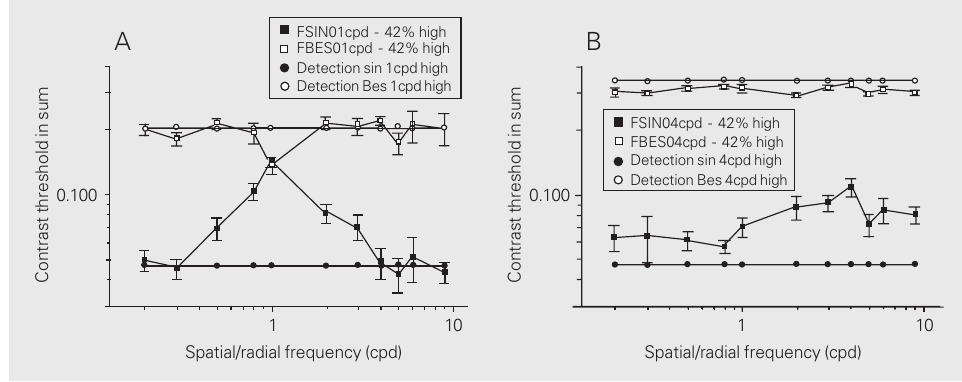
Figure 4. Contrast thresholds of test frequency in the summed stimuli obtained with the high-contrast resolution monitor. A , Grand mean of contrast at threshold in sum for the test frequency used to estimate FSIN01cpd and FBES01cpd. These are measurements using the high-contrast resolution monitor (please, note the higher ordinate values at low luminance). Again the background frequencies had contrast fixed at 42%. Horizontal lines are detection thresholds for the 1.0-cpd sine-wave grating and for the 1.0-cpd radial frequency. Again, observe the difference in trends (refer also to Figure 3A and C). For FSIN01cpd, the test frequency of 1.0 cpd fell significantly above the 1.0-cpd sine-wave grating absolute detection threshold. Neighboring point estimates at 0.5, 0.8, 2.0, and 3.0 cpd also showed significant inhibition. On the other hand, point estimates for the FBES01cpd showed a significant summation effect at 1.0-cpd radial frequency (the test frequency), and still showed significant inhibitory effects at neighboring frequencies, i.e., at 0.5-0.8 and 2.0-4.0 cpd. B , Grand mean of contrast at threshold in sum for the test frequency used to estimate FSIN04cpd and FBES04cpd with background stimulus contrast at 42%. Horizontal lines are detection thresholds for the 4.0-cpd sine-wave grating and for the 4.0-cpd radial frequency. While all point estimates for FSIN04cpd fell above the 4.0-cpd sine-wave grating absolute detection threshold, showing general inhibition with a maximum significant effect at 4.0 cpd, point estimates for the FBES04cpd fell all below the absolute contrast threshold value for the 4.0-cpd radial frequency. At that low luminance level, summation was stronger at 2.0 instead of 4.0 cpd with a secondary minimum at 5.0 cpd. All error bars are standard errors of the mean and corrected for the sample size to be at the 99% level of confidence interval. All inhibitory effects are reported relative to the test frequencies. cpd = cycles per degree of visual